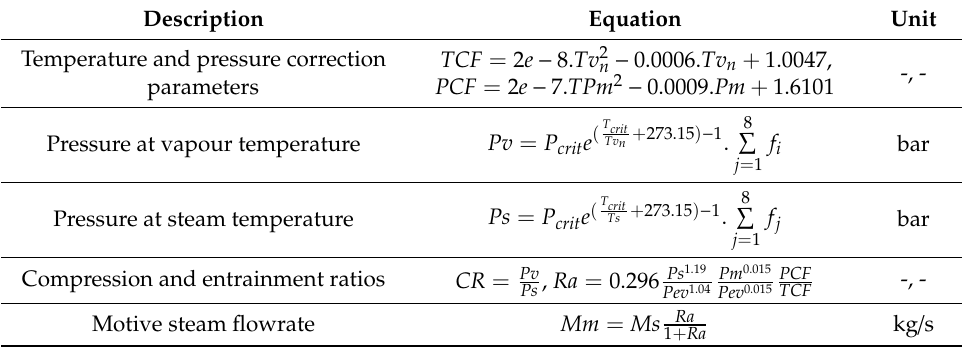
Table A5. Mathematical model of thermal vapour compression part